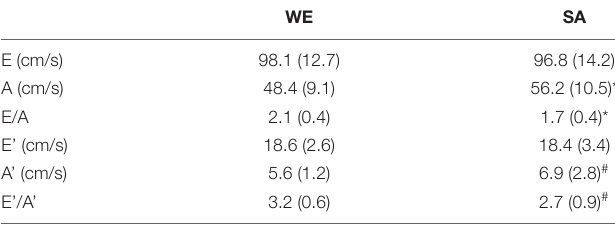
TABLE 3 | Ethnic difference in Children’s diastolic function.